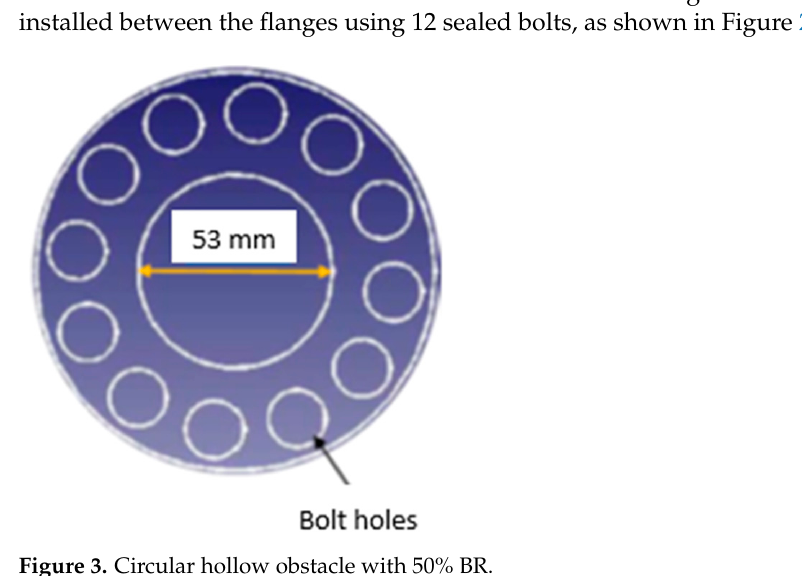
Figure 3. Circular hollow obstacle with 50% BR.